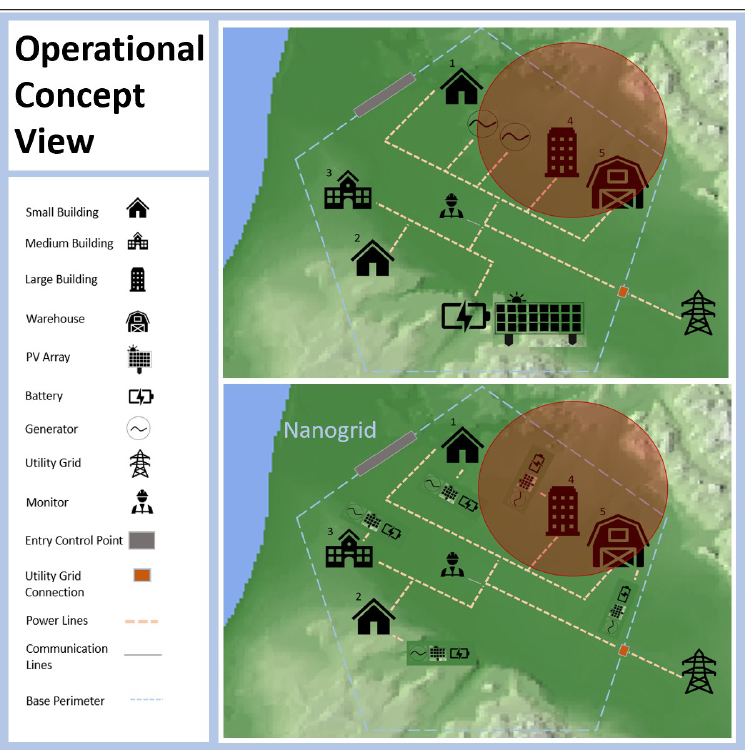
Figure 7. Threat of Fire Operational Concept View. The large shaded red circle indicates area destroyed by fire. In the microgrid scenario (top), the fire destroys the warehouse and large office building (Critical Loads 4 and 5), and both diesel generators. In the nanogrid scenario, the same buildings and associated nanogrids are